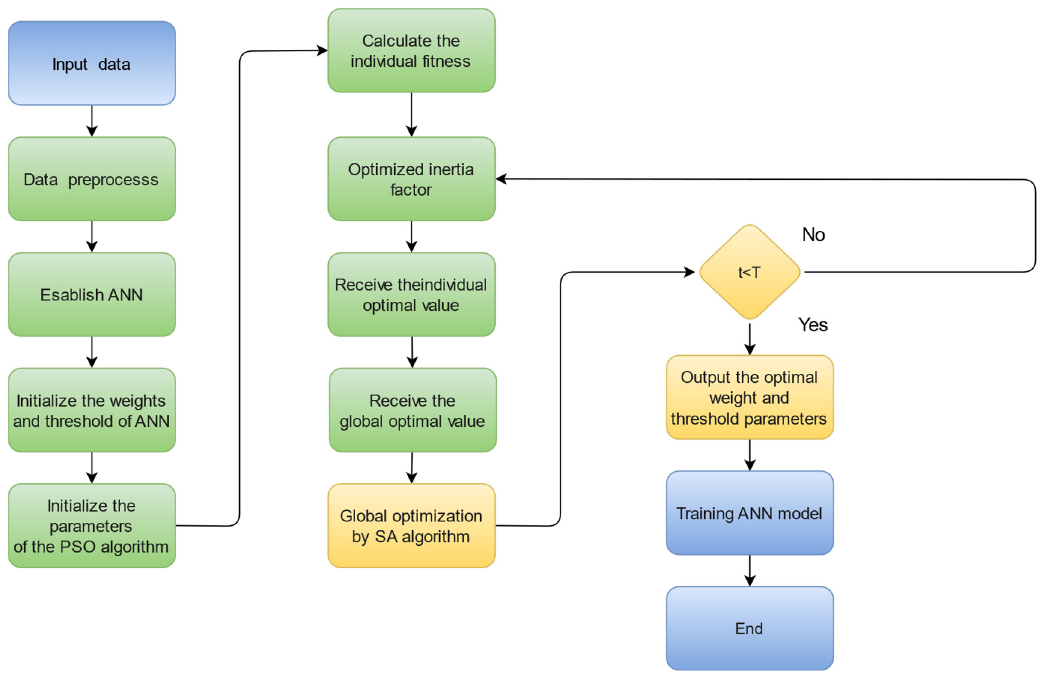
Figure 5. Workflow of the ASAPSO-ANN model.